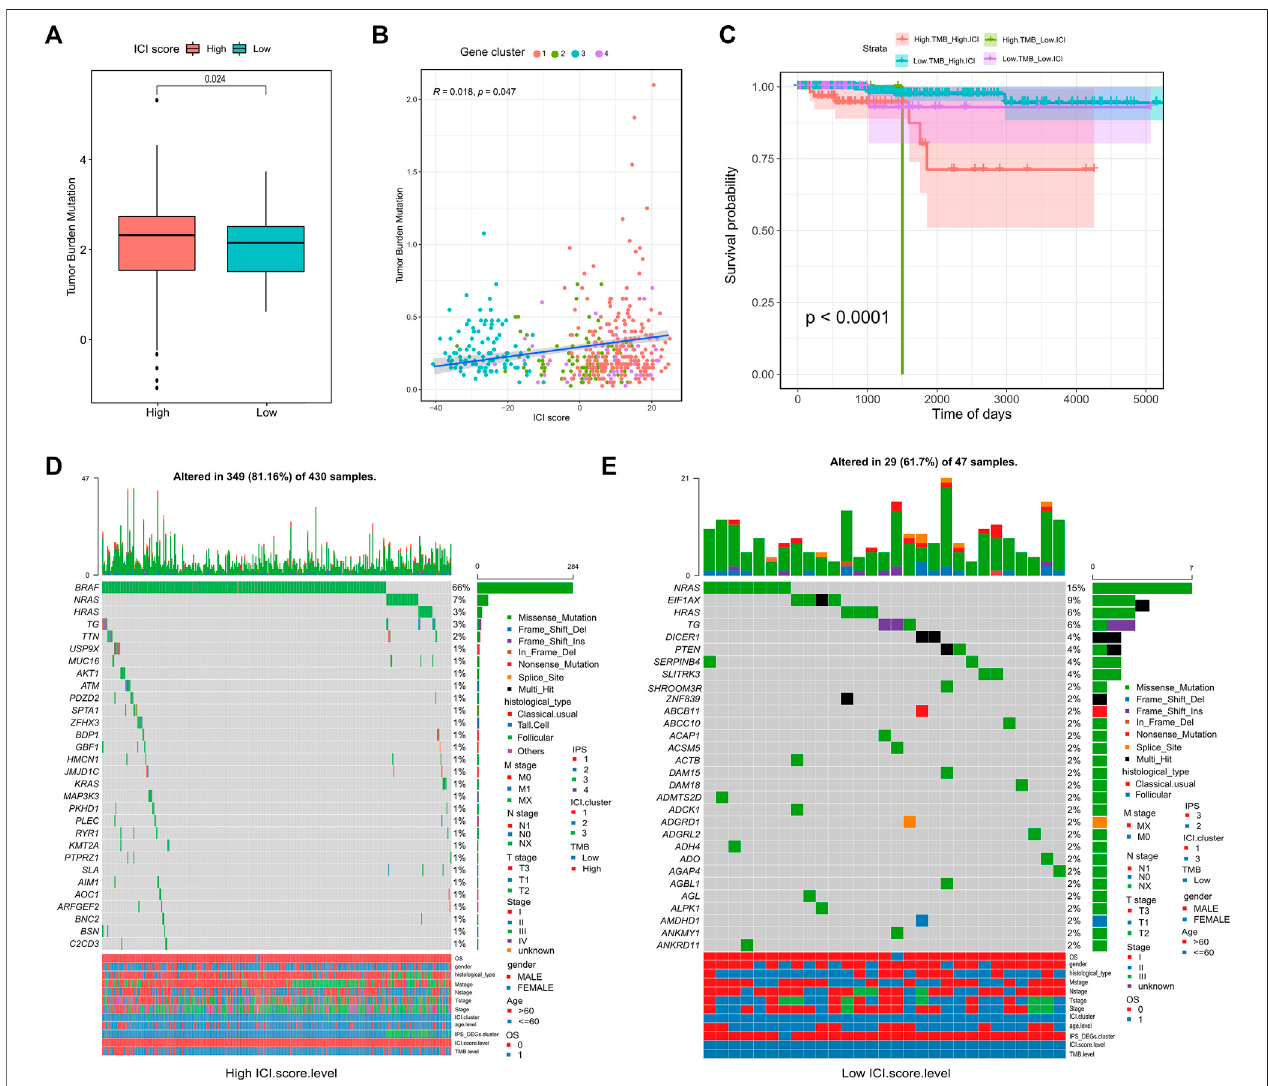
FIGURE 4 | Correlation between ICI scores and Somatic Variants. (A) Tumor mutation burden (TMB) between high and low ICI scores groups; (B) Association between ICI scores and tumor mutation burden (TMB); (C) Survival curve between tumor mutation burden (TMB) and ICI scores groups; (D) waterfall chart of gene mutation distribution in tumors of high ICI scores group; (E) waterfall chart of gene mutation distribution in tumors of low ICI scores group.